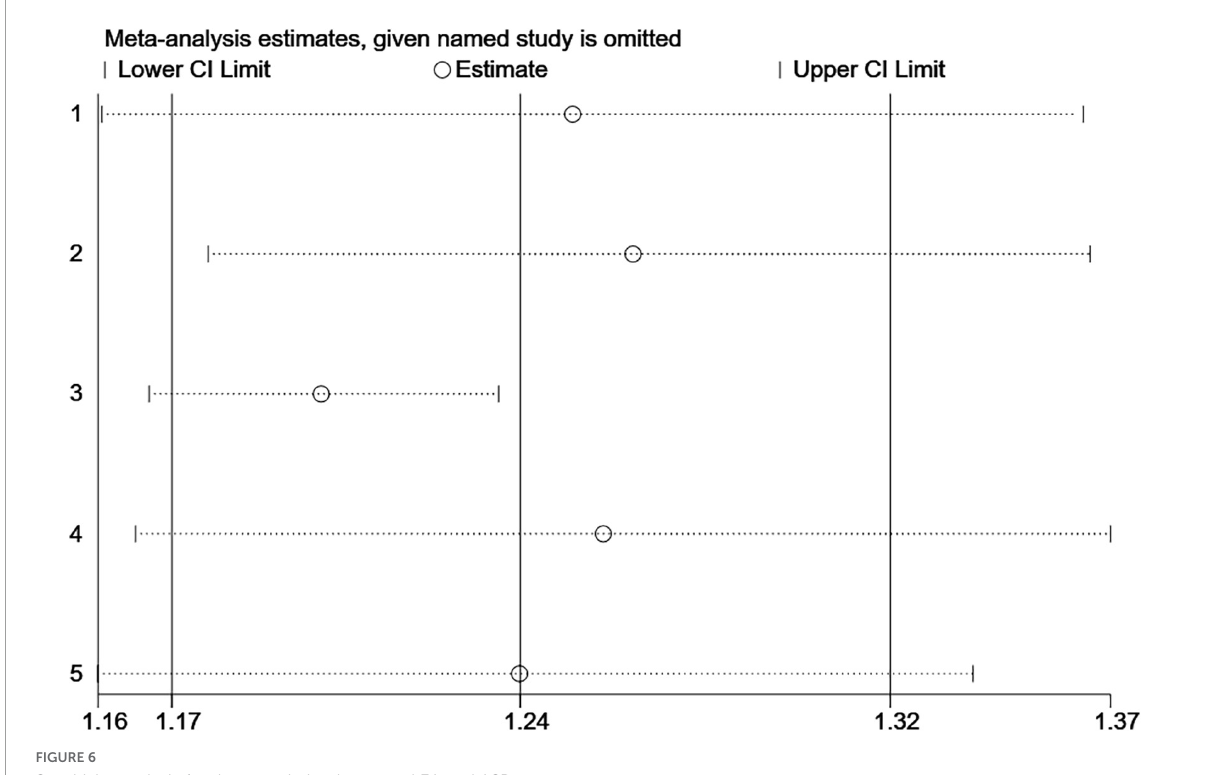
FIGURE6 Sensitivity analysis for the association between LEA and